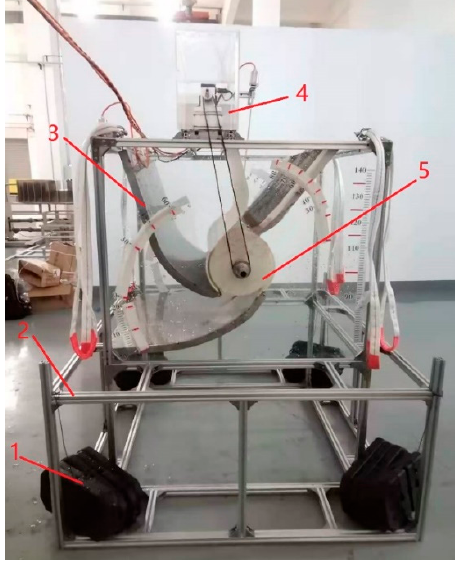
Figure 7. Physical model.